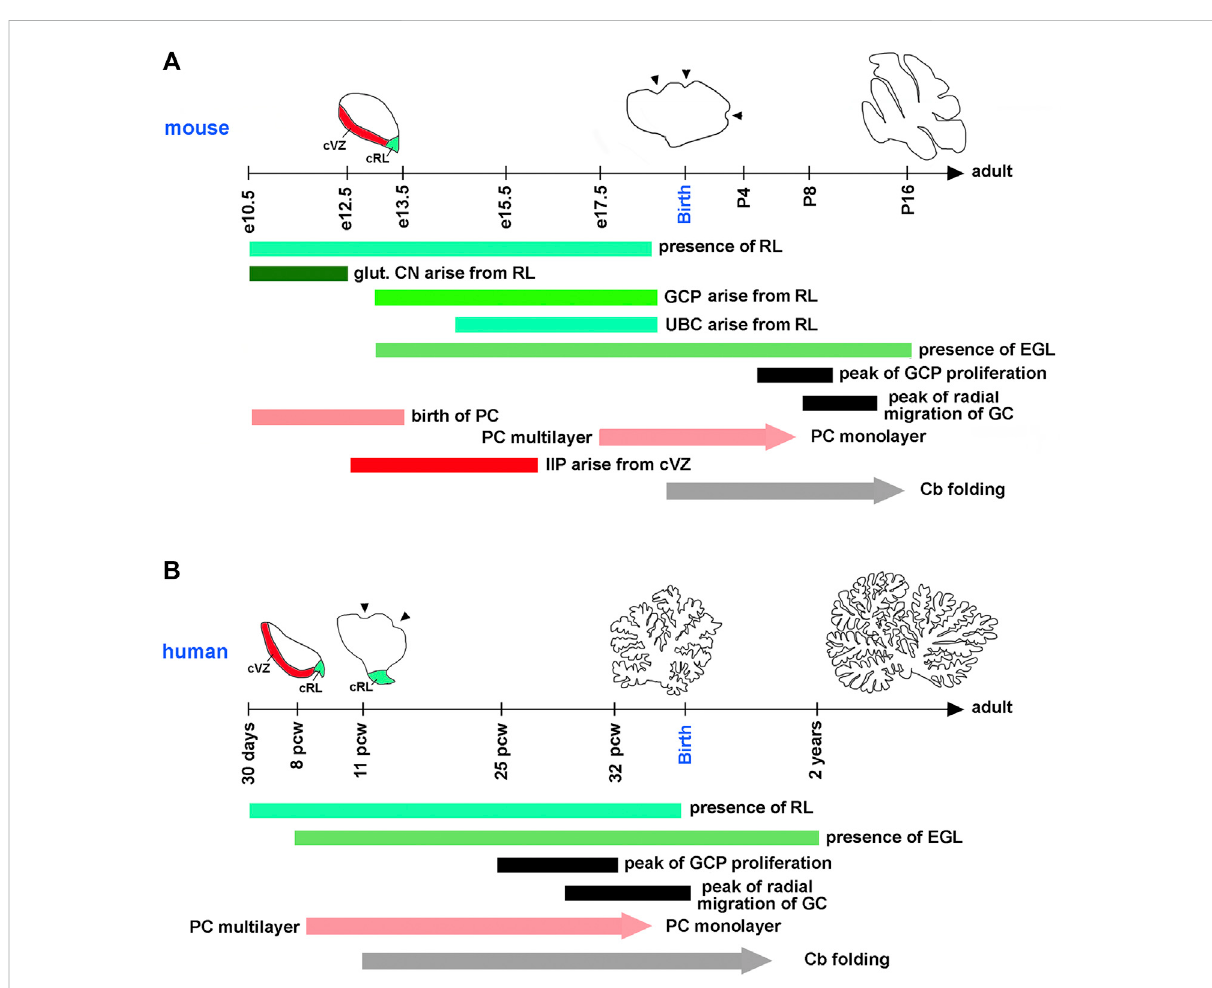
FIGURE 3 Timing of key cerebellar developmental events in the mouse and human. Horizontal axes show the mouse (A) and human (B) developmental timelines. On the mouse timeline, e and P mean embryonic and postnatal days, respectively. On the human timeline, pcw means postconceptual weeks. Diagrams showing the extent of cerebellar folding at selected developmental stages are shown above the timeline for each species. cRL and cVZ are shown at appropriate stages. Arrowheads point to fi ssures that begin forming on the outer cerebellar surface at species-speci fi c developmental stages. Horizontal bars indicate the duration of distinct developmental processes in each species. Since the re fi nement of Purkinje cells into the monolayer and the development of cerebellar foliation (Cb folding) are gradual processes, they are shown as arrows. glut. CN — glutamatergic neurons of cerebellar nuclei. All other abbreviations are de fi ned in legends for Figures 1, 2. Compared to the mouse, human embryoniccerebellardevelopmentishighlyprotracted.Manykeycerebellardevelopmentaleventsthatoccurinthemouseafterbirth,inhumansare initiated or even completed in utero